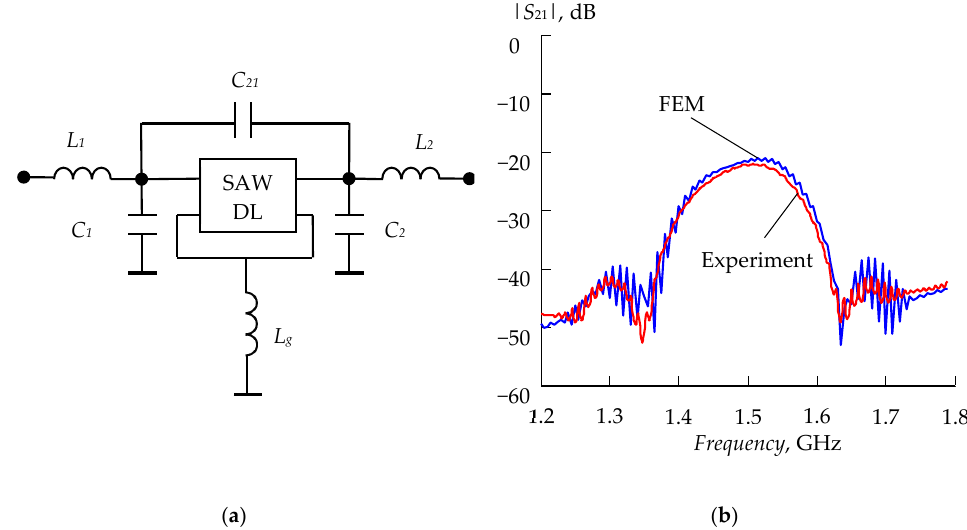
Figure 9. SAW DL: ( a ) scheme with “parasitic” LC elements; ( b ) frequency response calculated by FEM and experiment for scheme with “parasitic” LC elements.